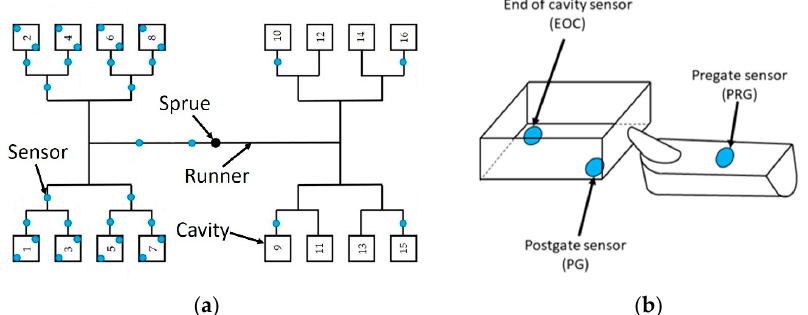
Figure 2. Injection mold and the pressure sensor (blue dots) positions: ( a ) general scheme of the runner system with cavities; ( b ) sensor locations and their names in the first cavity. Table 1. The unchanged settings of injection molding.